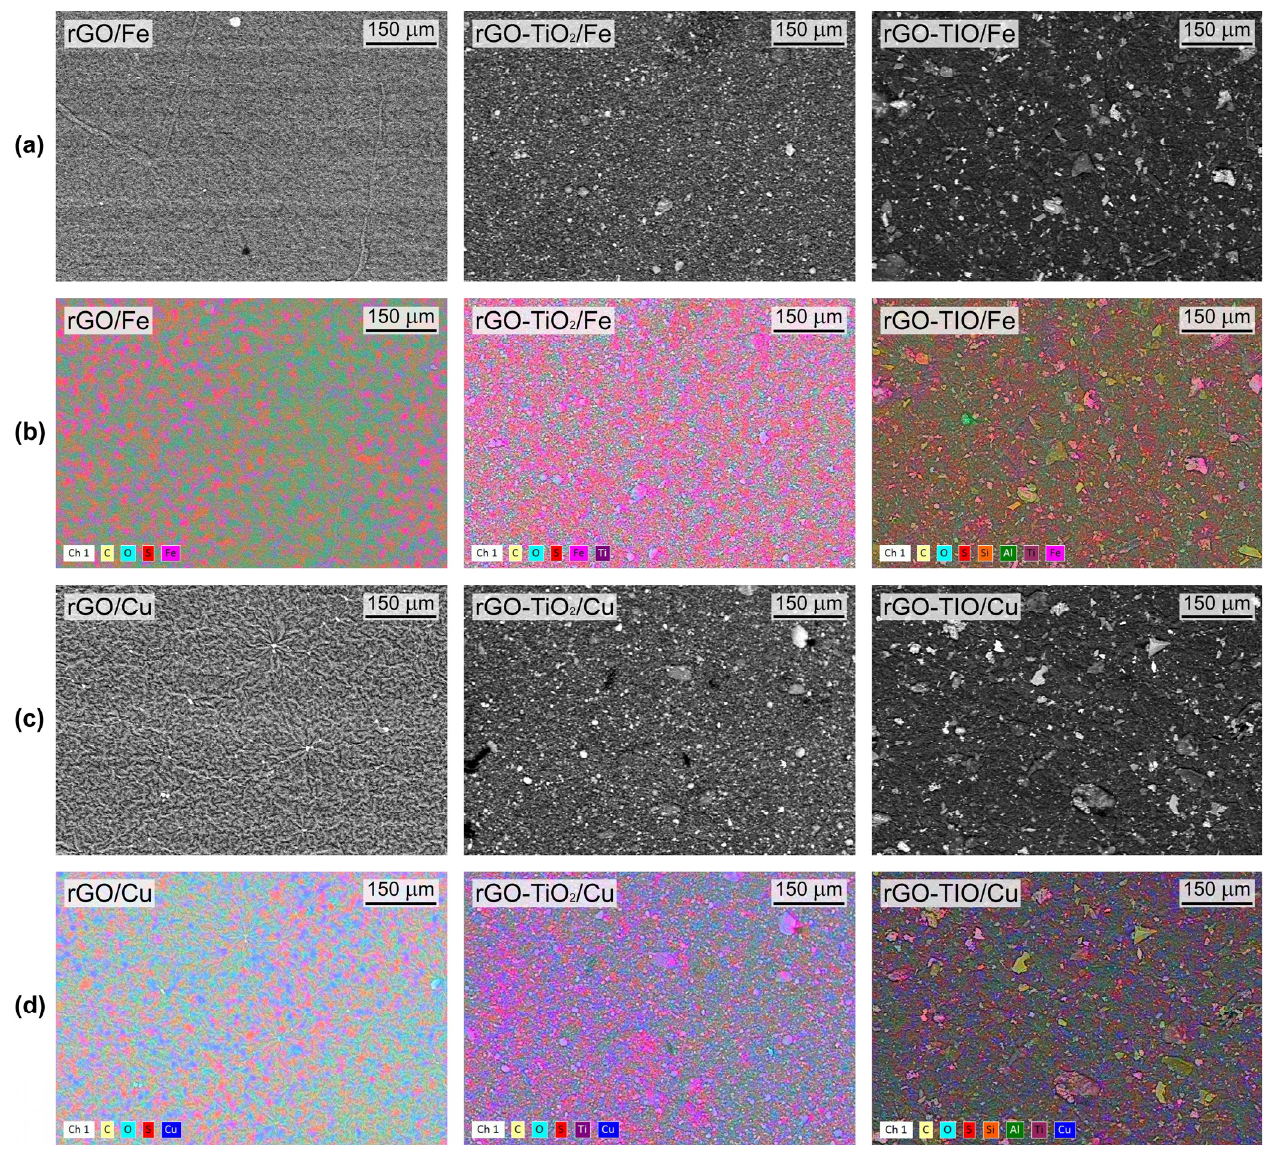
Figure 8. SEM pictures of rGO ( left ), rGO–TiO 2 ( middle ), and rGO–TIO ( right ) membranes: ( a ) backscattered electrons and ( b ) elements distribution after Fe capture; ( c ) backscattered electrons and ( d ) elements distribution after Cu capture.